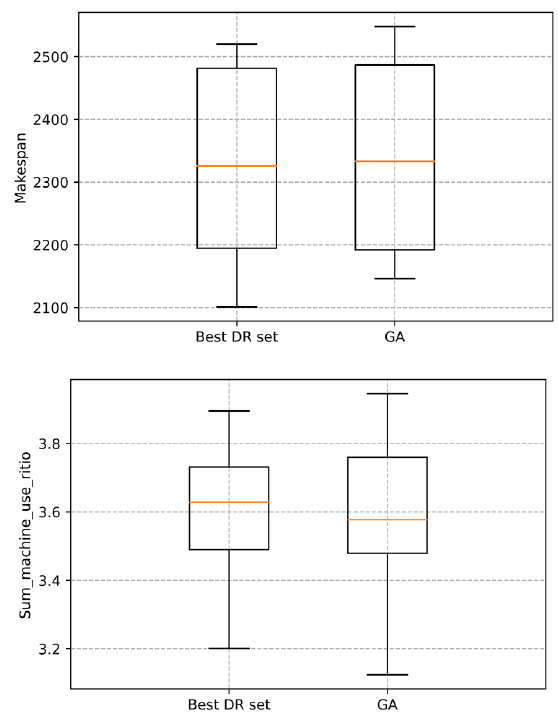
Figure 10. Low job heterogeneity and a high manufacturing system load rate.